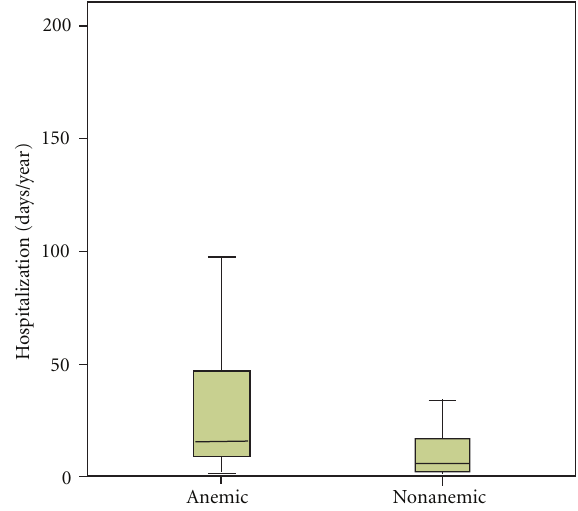
Figure 2: The hospitalization rate of anemic heart failure patients was significantly higher than in nonanemic patients ( P < 0 . 05). Boxplots represent median and interquartiles. The whiskers extend to 1.5 times the di ff erence between the first and third